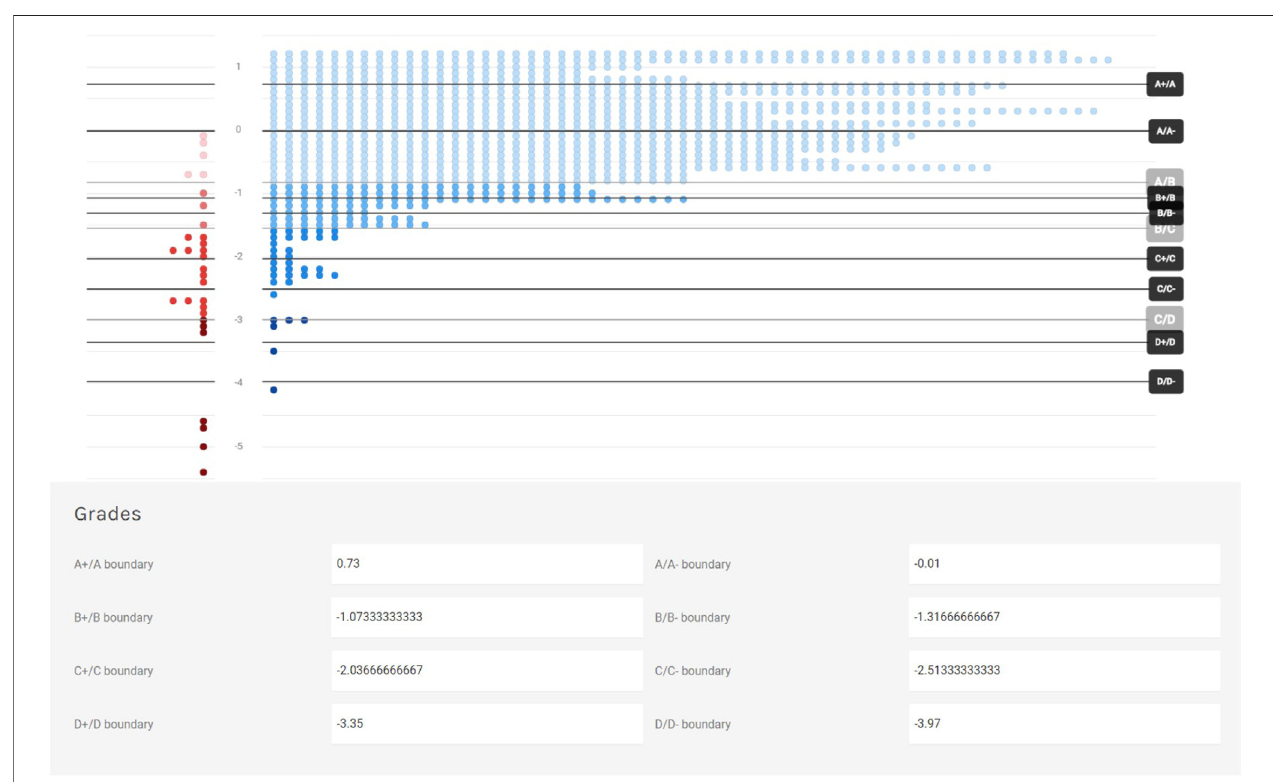
FIGURE 4 | SmartStandardSet standard setting display: Augmented grade boundaries.